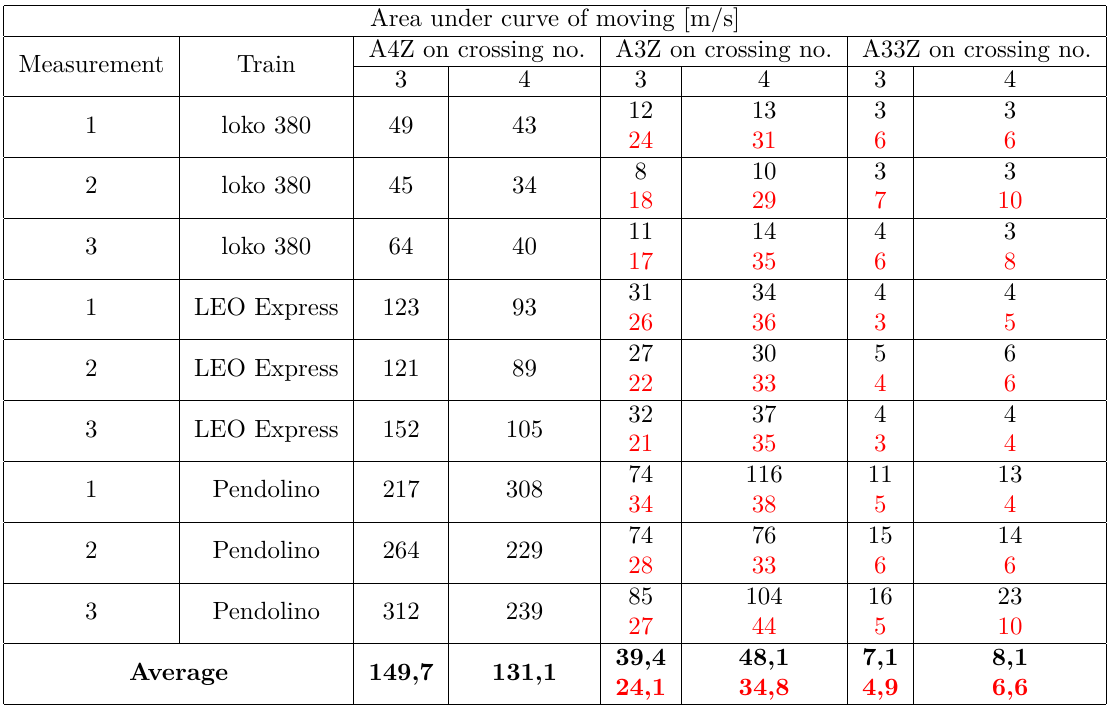
Table 1. Area under curve of moving RMS and the percentage transfer of dynamic energy from rail to sleeper and to ballast.